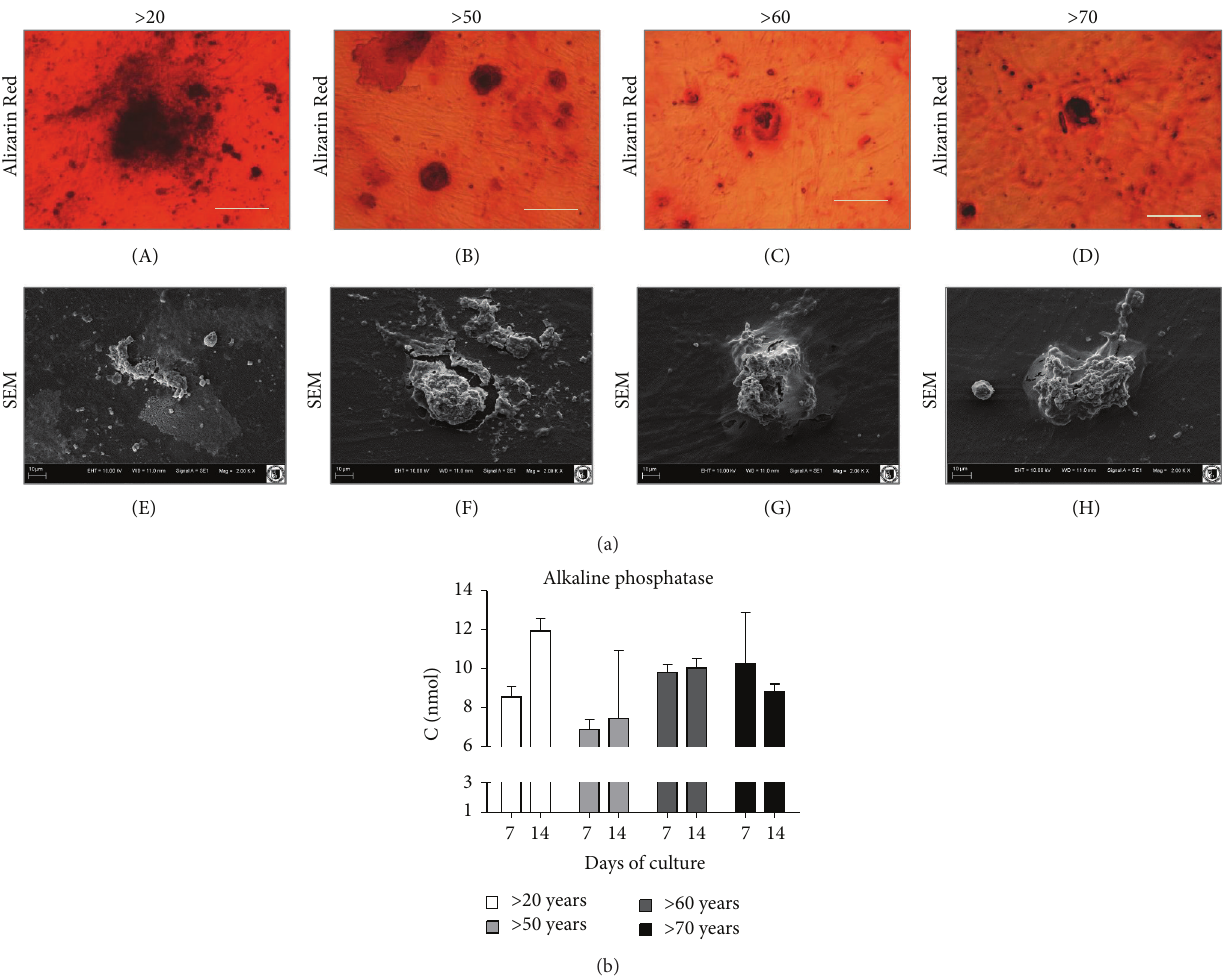
Figure7:CharacterizationofagerelatedchangesinhASCsosteogenicdifferentiationpotential.(a)Morphologyofcellsculturedinosteogenic medium visualized by (A–D) Alizarin Red staining and SEM (E–H). (b) SEM quantitative evalutaion of ALP secretion.